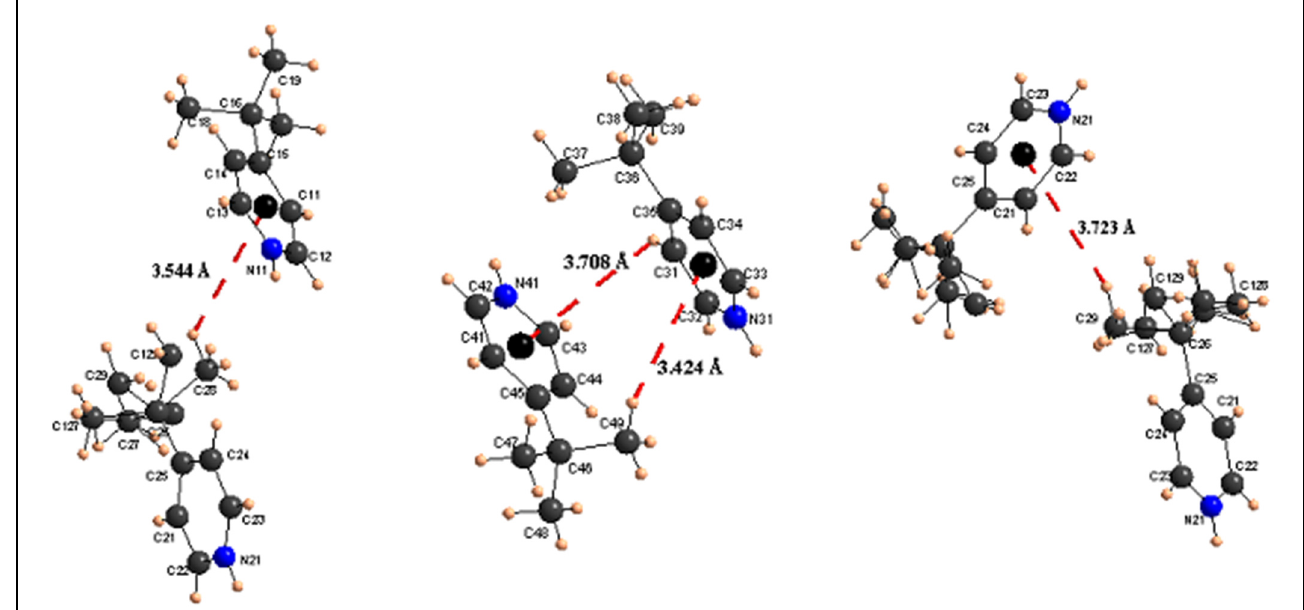
Figure 6. The interaction between the organic cations in the synthesized compound. Table 5. The enrichment ratios for the title